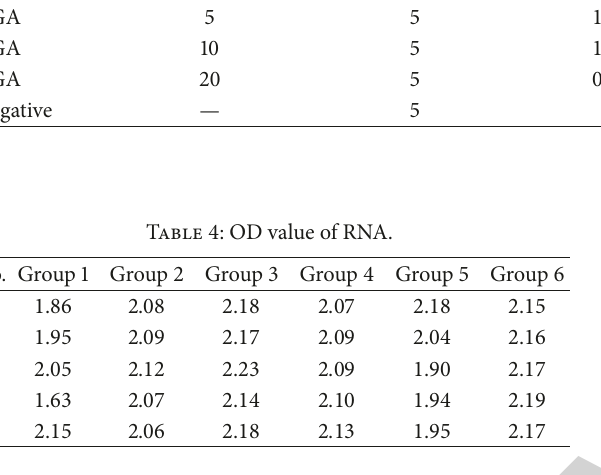
Figure 3: The EC of DX3 and blank.